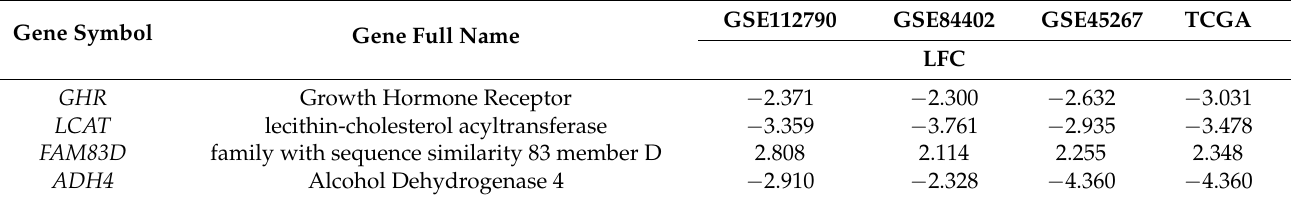
Table 2. Statistical information of differential analysis of candidate genes ( GHR , ADH4 , FAM83D and LCAT ). Log fold change (LFC) implies log fold change value and adjusted p -value less than